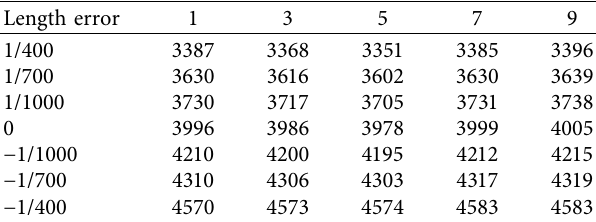
Table 4: Upper radial cable force ( N ).